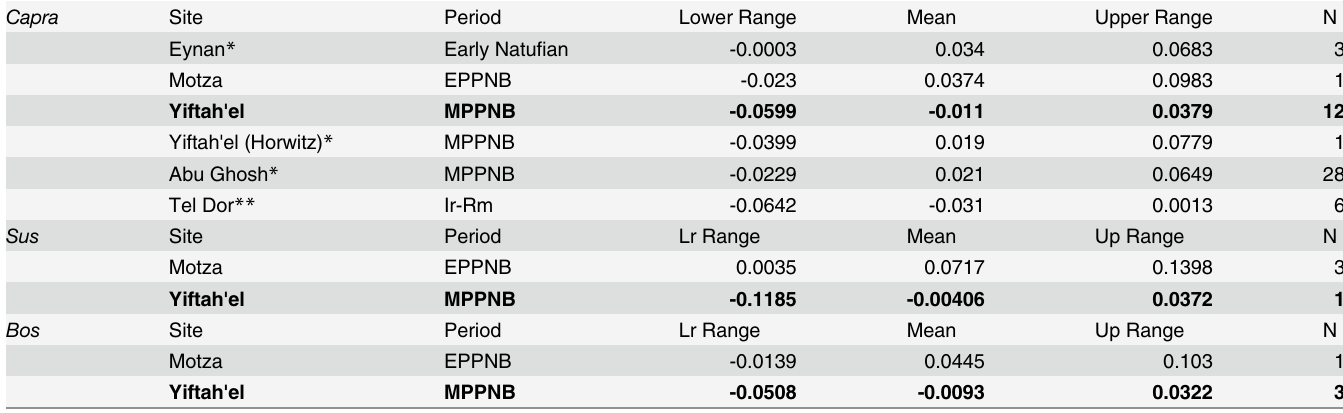
Table 5. Mean, upper and lower ranges (mean+/- 1 SD) of Capra , Sus and Bos LSI values for Yiftah'el, Motza and other applicable sites form the region. Size range and Mean, based on LSI values. Capra